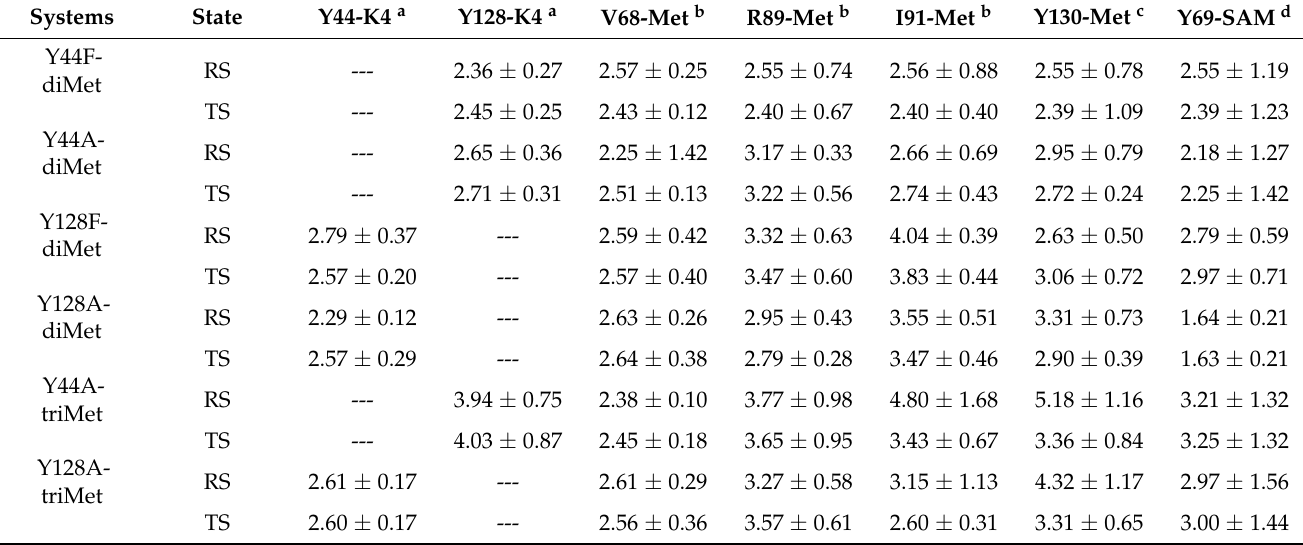
Table 4. Mean values for some selected interaction distances between the cofactor and substrate at the catalytic site, for both Y44F and Y128F mutants for their respective RS and TS for the di- and tri-methyl-transfer reactions. Distances are in Å and are provided with their corresponding standard